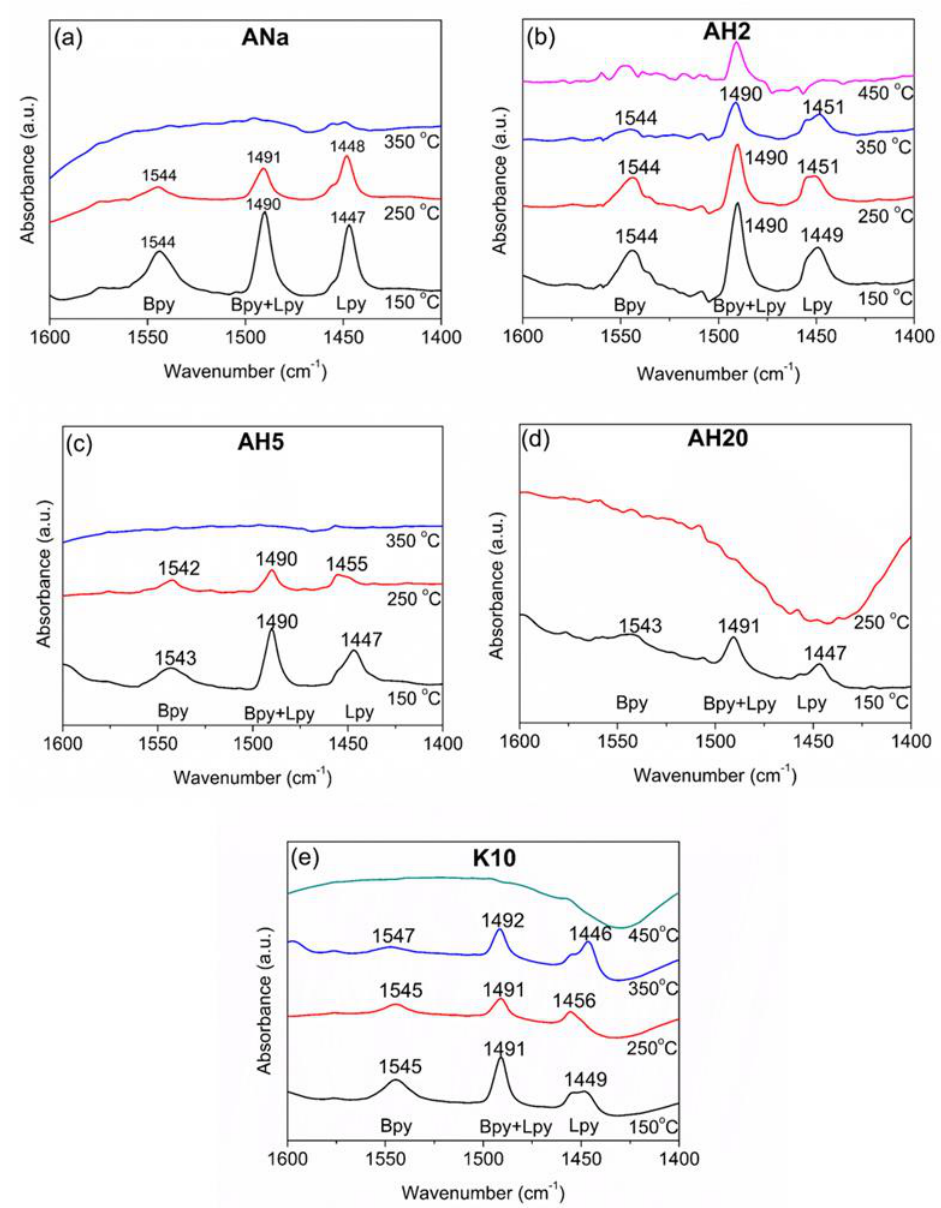
Figure 8. Fourier transform infrared (FTIR) spectra for pyridine after adsorption at 150 °C and desorption at increasing temperatures for clay minerals: ( a ) ANa; ( b ) AH2; ( c ) AH5; ( d ) AH20; ( e ) K10.